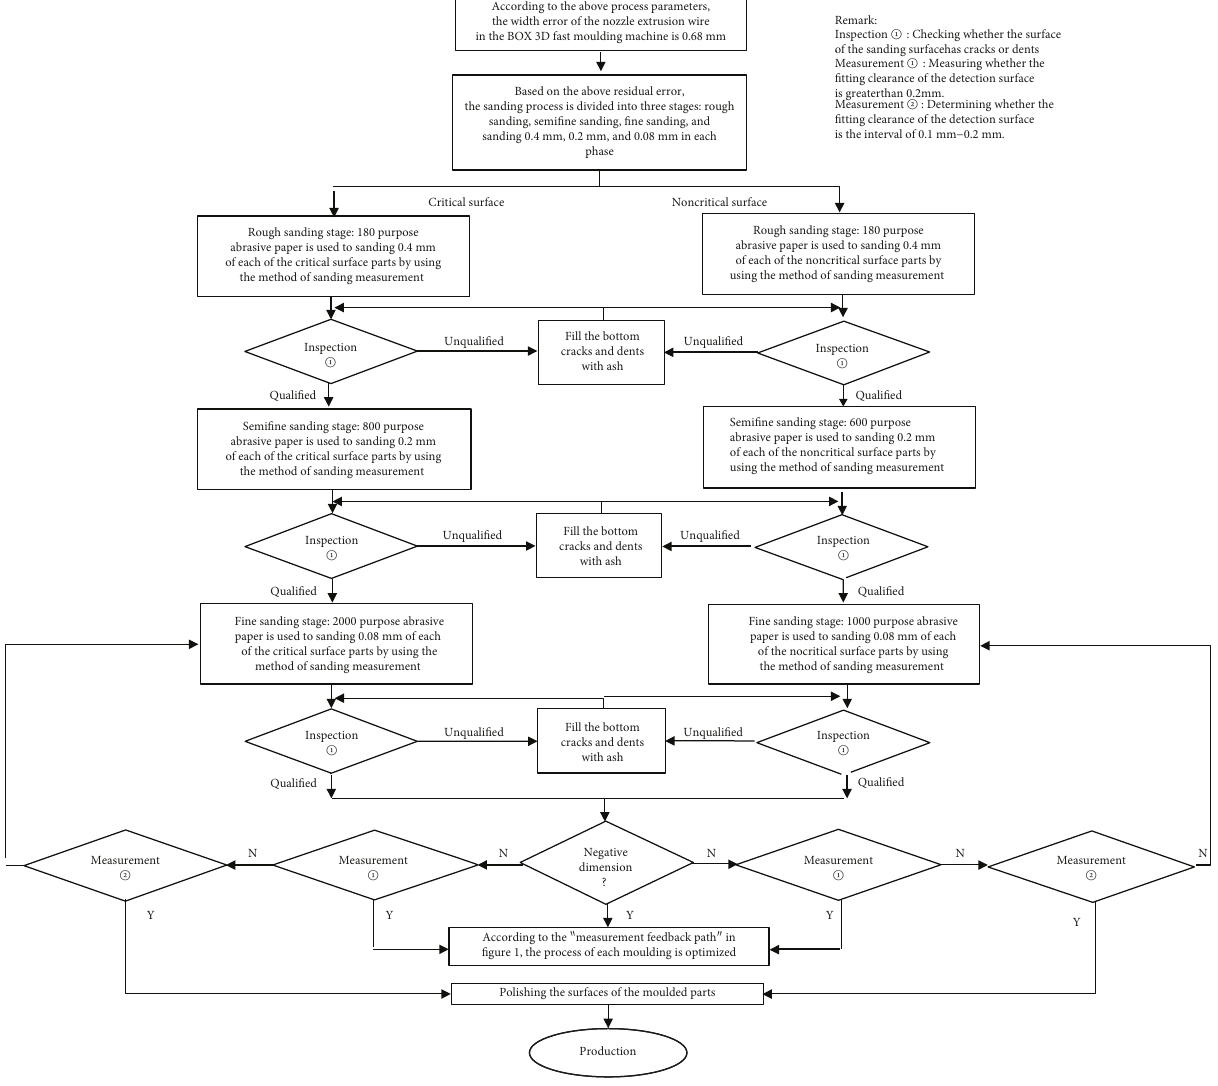
Figure 15: The postprocessing fl ow chart for the spur face gear master mould.